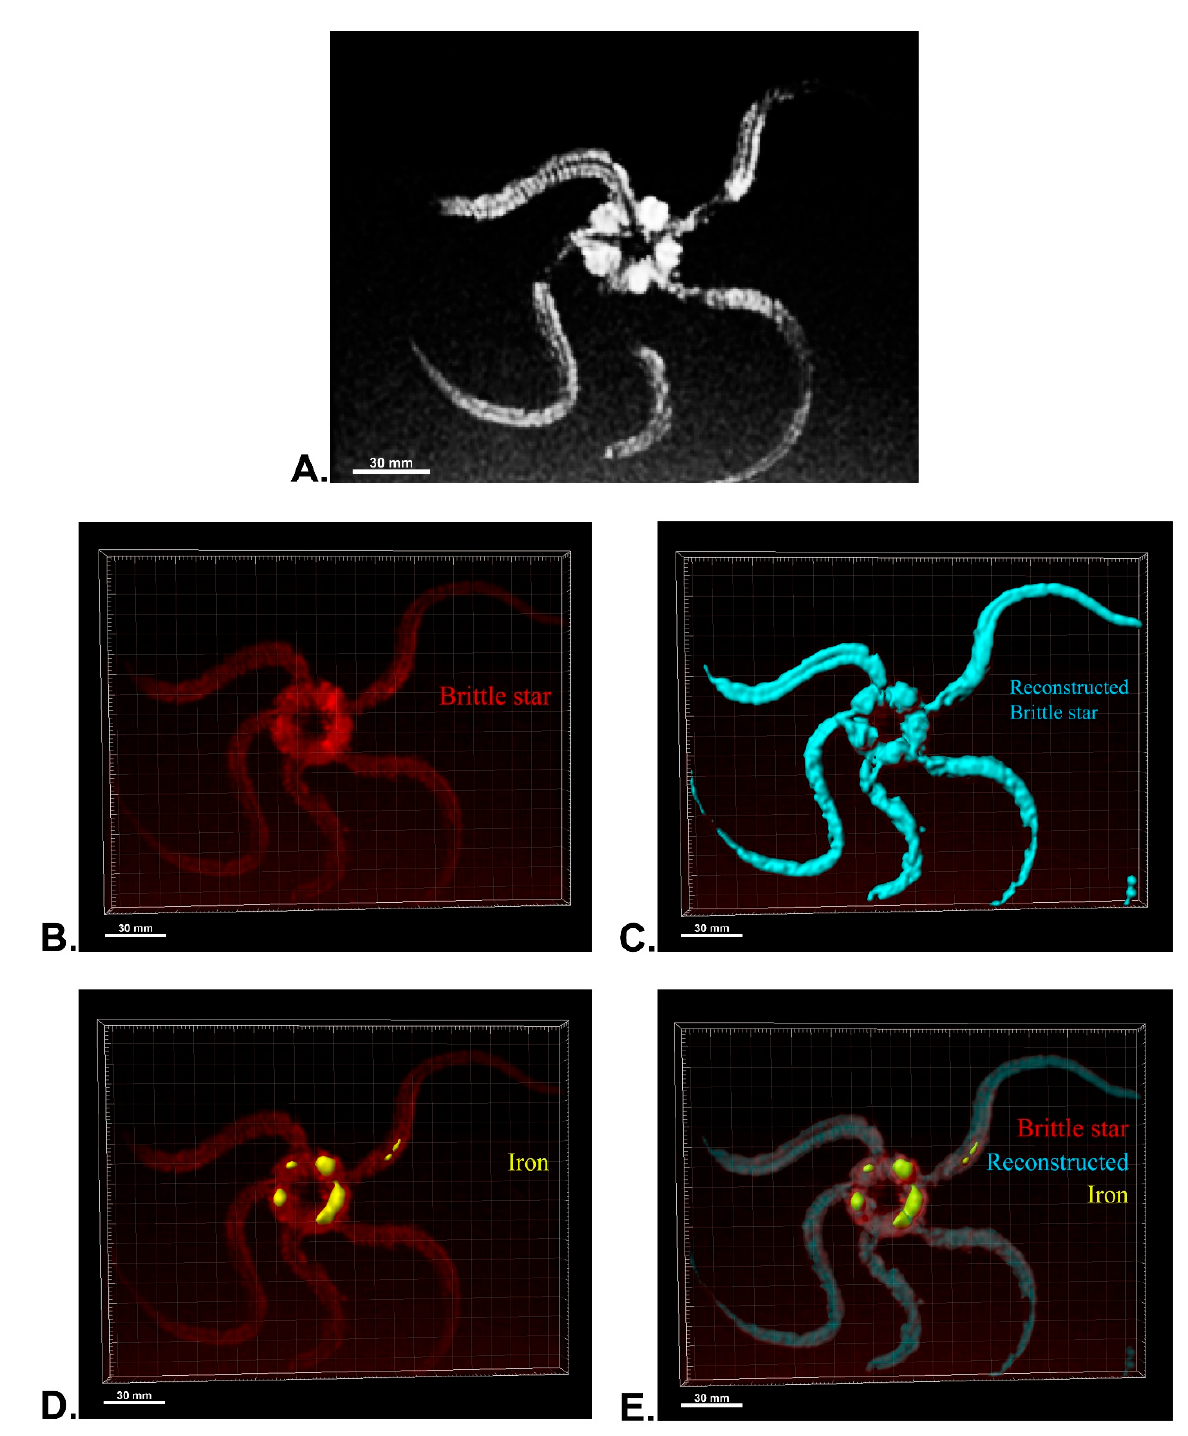
Figure 7. Three-dimensional (3D) reconstruction of brittle star tissue treated with iron using magnetic resonance imaging (MRI) serial images: ( A ) original grayscale image; ( B ) whole tissue imaging and signals of the brittle star tissue without reconstruction; ( C ) brittle star whole tissue 3D reconstruction in which the blue surface represents reconstructed brittle star tissue; ( D ) 3D reconstruction of the iron signals (shown in yellow); ( E ) 3D reconstruction of the whole tissue of brittle star with its all signals. All scale bars in four images are 30 mm. All images were processed and generated by Imaris software (V 7.4.2, ImarisX64; Bitplane AG).